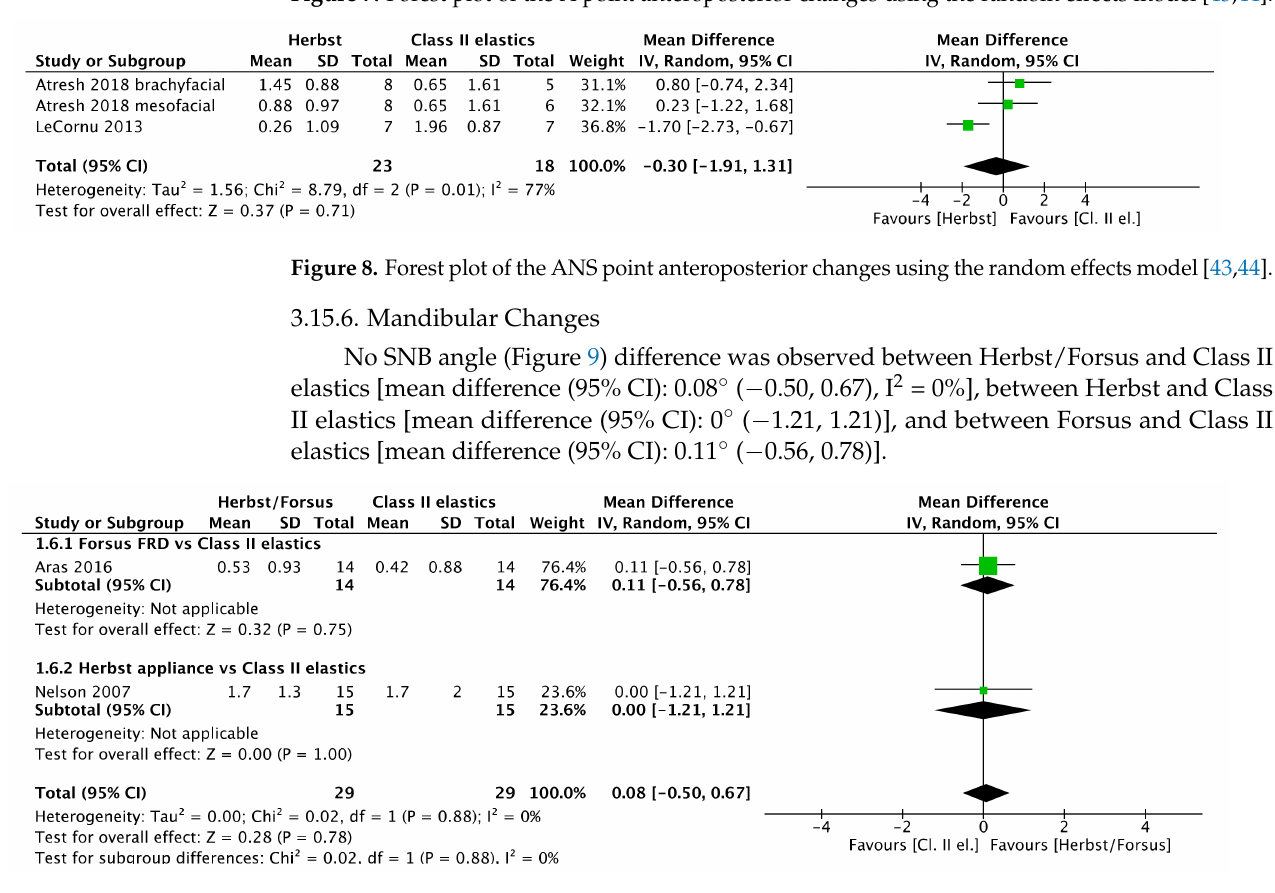
Figure 7. Forest plot of the A point anteroposterior changes using the random effects model [43,44].